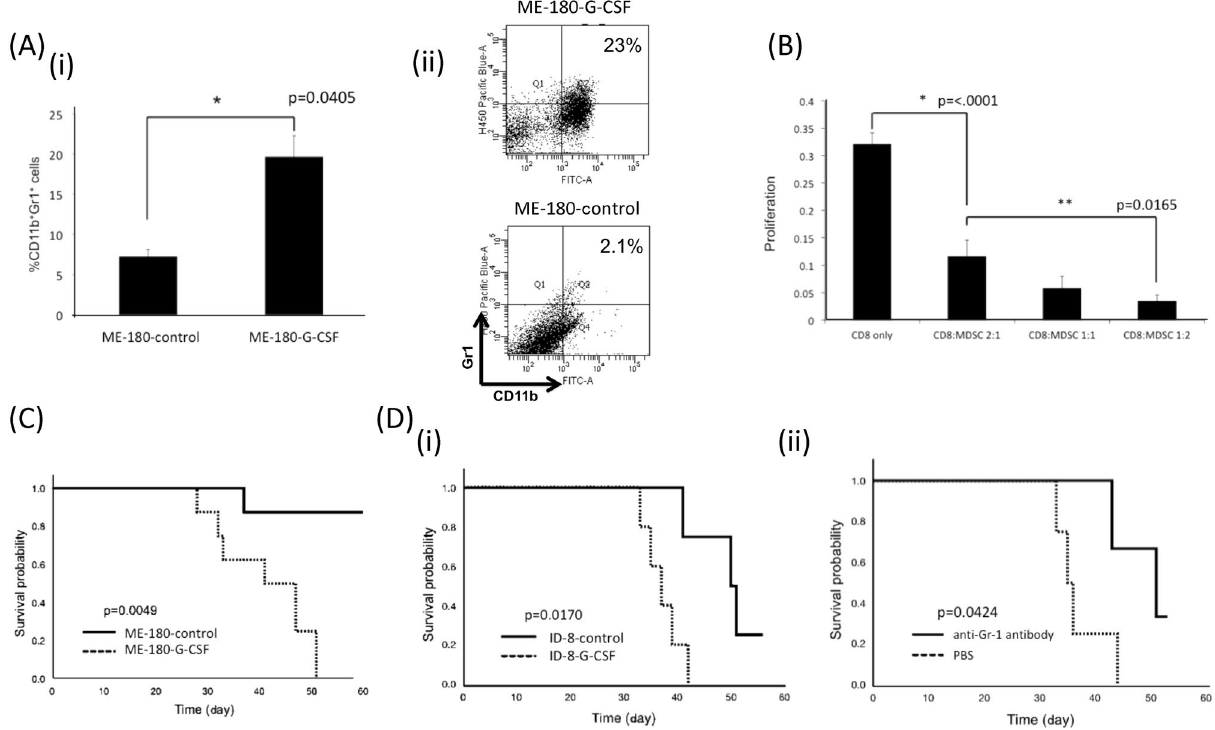
Figure 4. Roles of MDSCs and MDSC-mediated immune suppression in poor prognosis in patients exhibiting higher-BAR. ( A ) The effect of tumor-derived G-CSF on MDSC accumulation in subcutaneously inoculated tumors (mouse model of cervical cancer). ME180-G-CSF or ME180-control cells were subcutaneously inoculated into C57BL/6 mice (n = 6, for each group). Three weeks after the inoculation, their blood were collected for analyses. (i) CD11b + Gr-1 + cell populations in tumors. Bars, SD. *p < 0.05, Two-sided Student t test. (ii) Representative dot plot. ( B ) Suppressive activity of MDSCs. CD11b + Gr-1 + cells (MDSCs) were isolated from spleens of Balb/c mice subcutaneously inoculated with ME180-G-CSF. CD8 + T cells (2 × 10 5 cells/well) were isolated from syngeneic mice and co-cultured with MDSCs at the indicated ratios. Cells were incubated for 72 h, after which BrdU was added for an additional 24 h. T cell proliferation was determined by BrdU incorporation. Bars, SD. *p < 0.05, Two-sided Student’s t test. ( C ) Impact of tumor-derived G-CSF on the survival of mice bearing cervical cancer. ME180-G-CSF or ME180-control cells were subcutaneously inoculated into C57BL/6 mice (n = 6, for each group). Then, the survival rate was estimated using Kaplan–Meier method. ( D ) Impact of tumor-derived G-CSF and MDSC on the survival of ovarian cancer-bearing mice. (i) Impact of tumor- derived G-CSF on the survival of ovarian cancer-bearing mice assessed using the Kaplan–Meier method. (ii) Effects of MDSC-inhibition using an anti-Gr-1 antibody on the survival of G-CSF-expressing ovarian cancer. Immunocompetent C57BL/6 mice were subcutaneously inoculated with 1.0 × 10 6 ID-8 cells/mouse. Fourteen days after inoculation, mice were randomized into 2 groups that were administered either Gr-1 antibody (n = 5) or PBS (n = 5), every other day (day 14, 16, 18, 20). Kaplan–Meier estimates of survival is